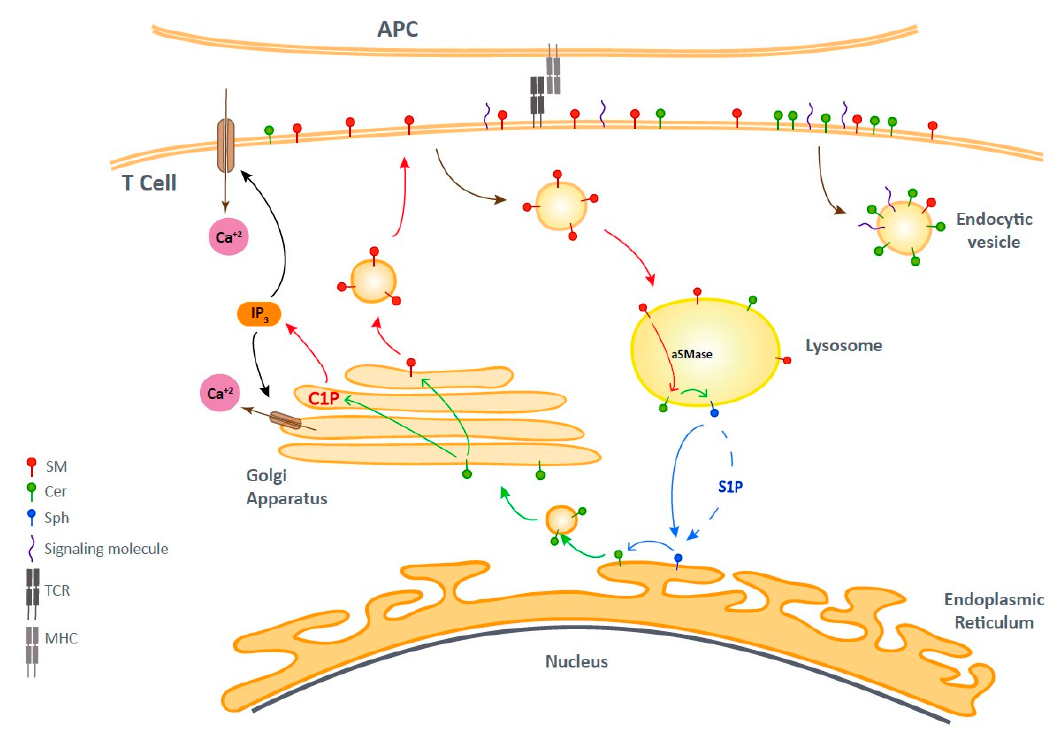
Figure 2. The cycle of bioactive sphingolipids upon T cell activation. T cell receptor (TCR) stimulation produces endocytic vesicles that regulate signaling. Sphingomyelin (SM) transport to lysosomes by endocytic vesicles allows its conversion to Cer and Sph. Then, the direct or mediated arrival of Sph to the endoplasmic reticulum (ER) leads to its re-conversion into Cer, which goes to the GA through vesicular transport. In the GA, Cer is phosphorylated and ceramide-1-phosphate (C1P) induces Inositol-1, 4, 5-trisphosphate (IP 3 ) production, leading to an opening of plasma membrane and ER Calcium channels that regulates TCR signaling. Besides that, in the ER, Cer is converted to SM, which is then recycled to the plasma membrane, thereby ending the cycle. TCR: T Cell Receptor; Cer: Ceramide; Sph: Sphingosine; ER: Endoplasmic Reticulum; GA: Golgi Apparatus; C1P: Ceramide-1-Phosphate; IP 3 : Inositol-1, 4, 5-trisphosphate.